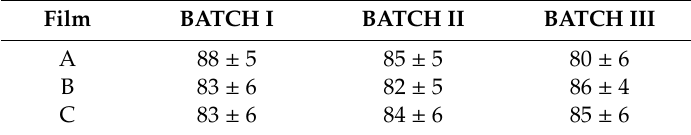
Table 1. Film thickness values (µm) obtained from three different films (A, B and C) of each batch. Data are expressed as mean of five measurements performed at different random points ± standard deviation.